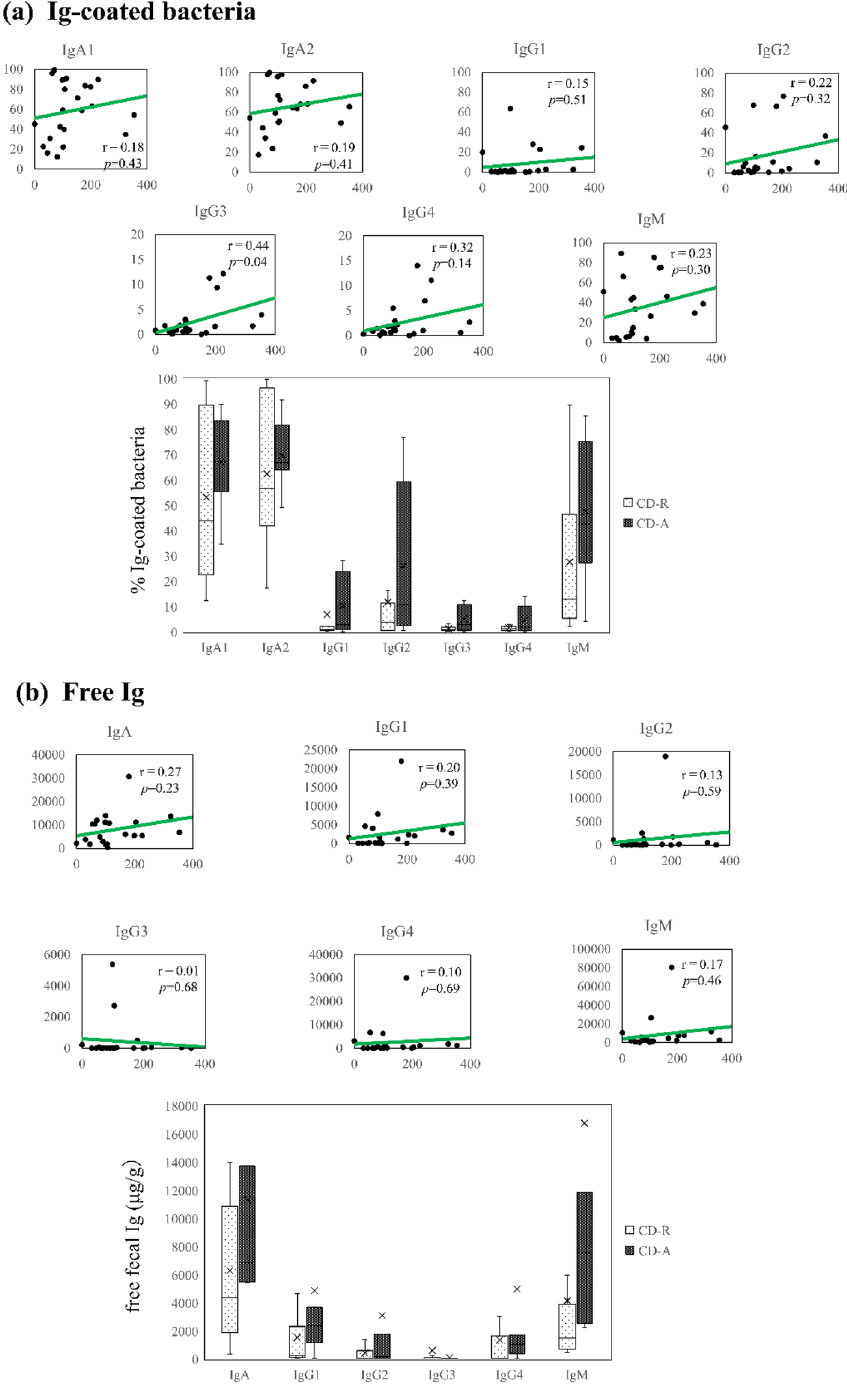
Figure 3. Correlation between CD activity as well as Ig-coated bacteria and fecal free Ig concentration. ( a ) The correlation between the ratio of each Ig-coated bacteria and the CDAI score is shown in the graph. The CDAI score was obtained at the time of fecal sample collection (n = 22). ( b ) Box plot showing the flow cytometry analysis results for the ratio of each Ig-coated bacteria in the CD-A (n = 8) and CD-R (n = 14) samples. CD-A was more correlated with the ratio of each Ig-coated bacteria than CD-R. Disease activity was defined based on the CDAI score. ( c ) The CDAI score was correlated with the concentration of each fecal free Ig. ( d ) Box plot showing the concentration of each fecal free Ig in the CD-A (n = 8) and CD-R (n = 11) samples. Unlike CD-R, CD-A was not correlated with the concentration of each fecal free Ig. Spearman’s correlation analysis was performed, and the straight line in graphs ( a ) and ( c ) is the regression line. The brackets in graphs ( b ) and ( d ) indicate significant differences. Wilcoxon rank-sum test. p -values are shown * < 0.05, **< 0.005. Student’s t -test. p -values are shown † < 0.05, †† < 0.005). CD Crohn’s disease, CDAI Crohn’s Disease Activity Index, CD-A Crohn’s disease in the active phase, CD-R Crohn’s disease in the active